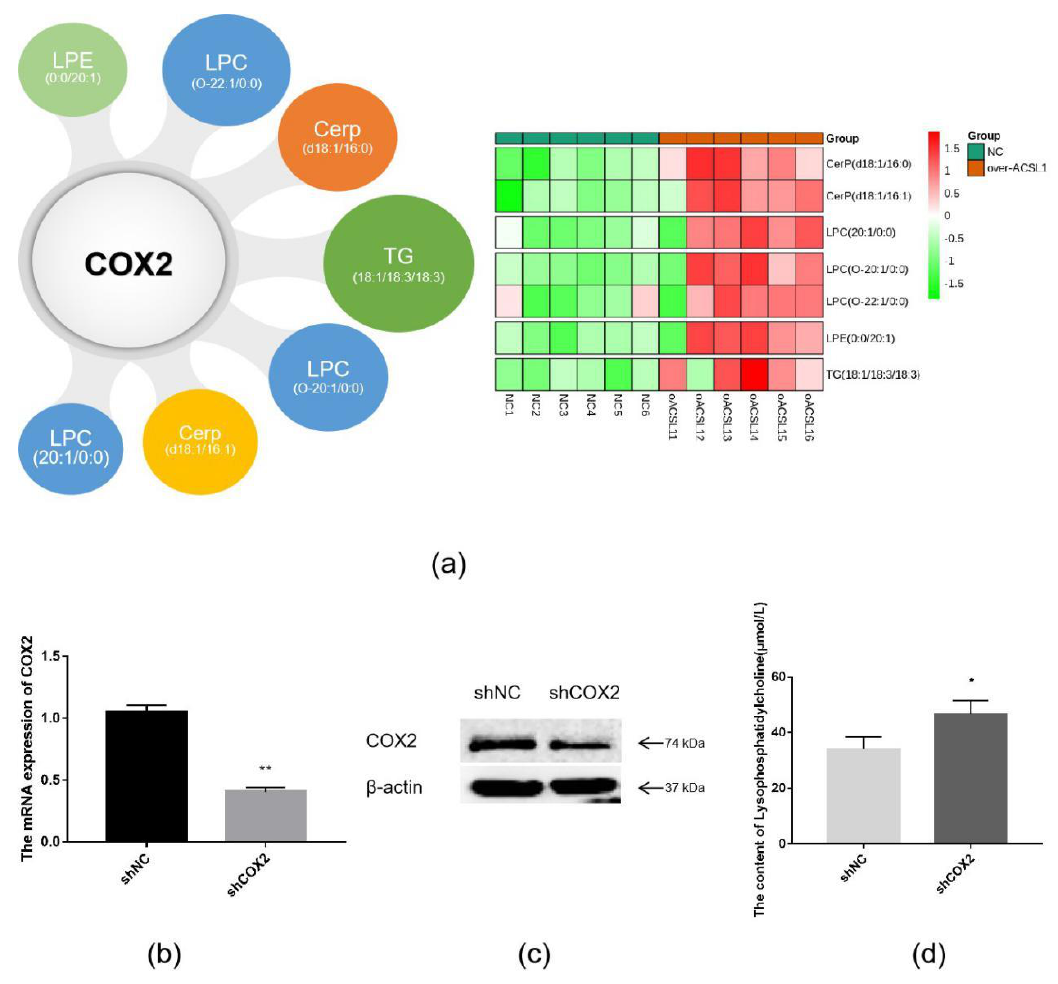
Figure 8. ( a ) Joint analysis of di ff erential metabolites associated with COX2 ; ( b ) COX2 mRNA expression on day 8 of di ff erentiation (** p < 0.01); ( c ) COX2 protein expression on day 8 of di ff erentiation; ( d ) the detection of intracellular LPC content (* p < 0.05). shNC: Adipocytes transfected with shNC as control. ShCOX2: Adipocytes transfected with shRNA-1676 of the COX2 gene.